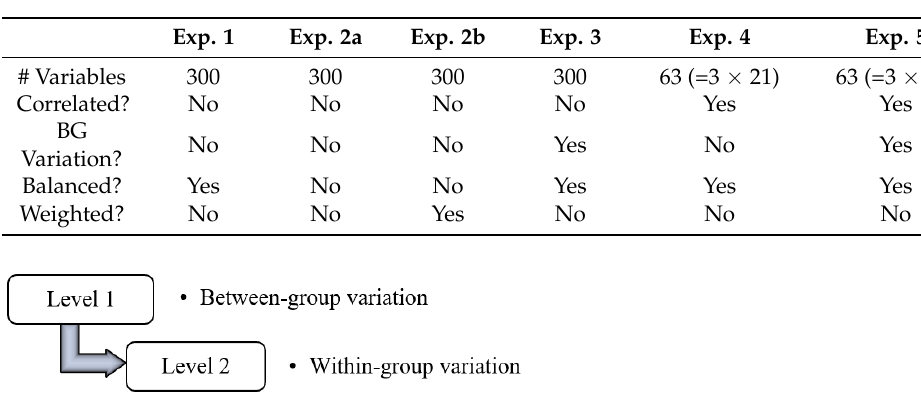
Figure 2. Schematic of a two-level multilevel model used here in mPCA calculations.